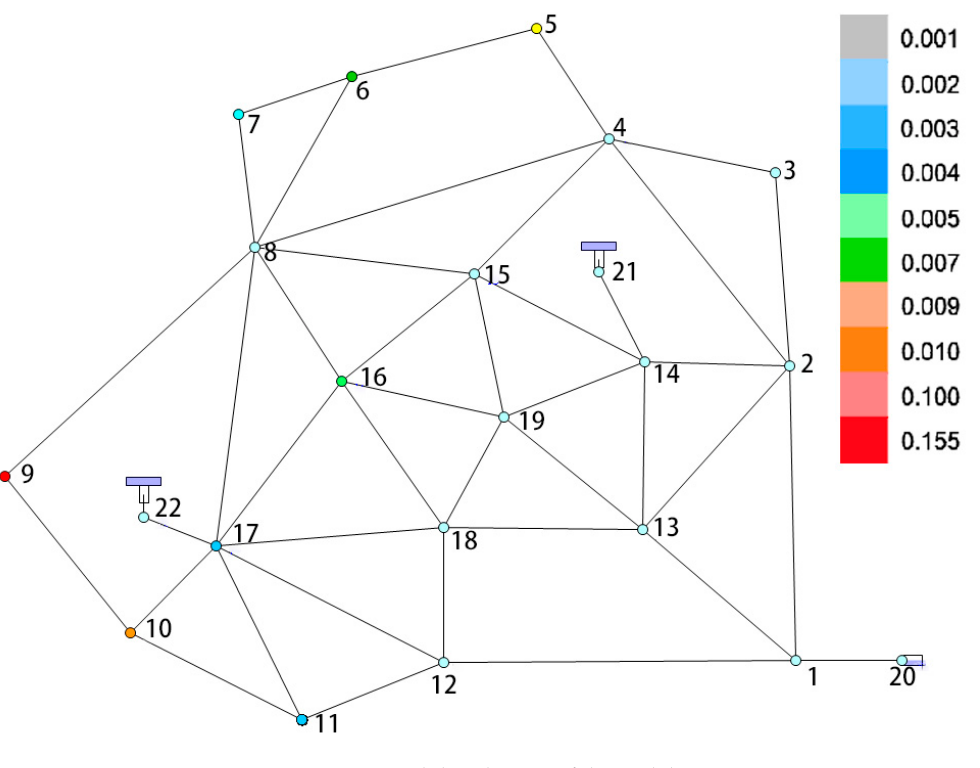
Water 2020 , 12 , x FOR PEER REVIEW Figure 1. Expected distribution of the nodal DFR. Figure 1. Expected distribution of the nodal DFR .